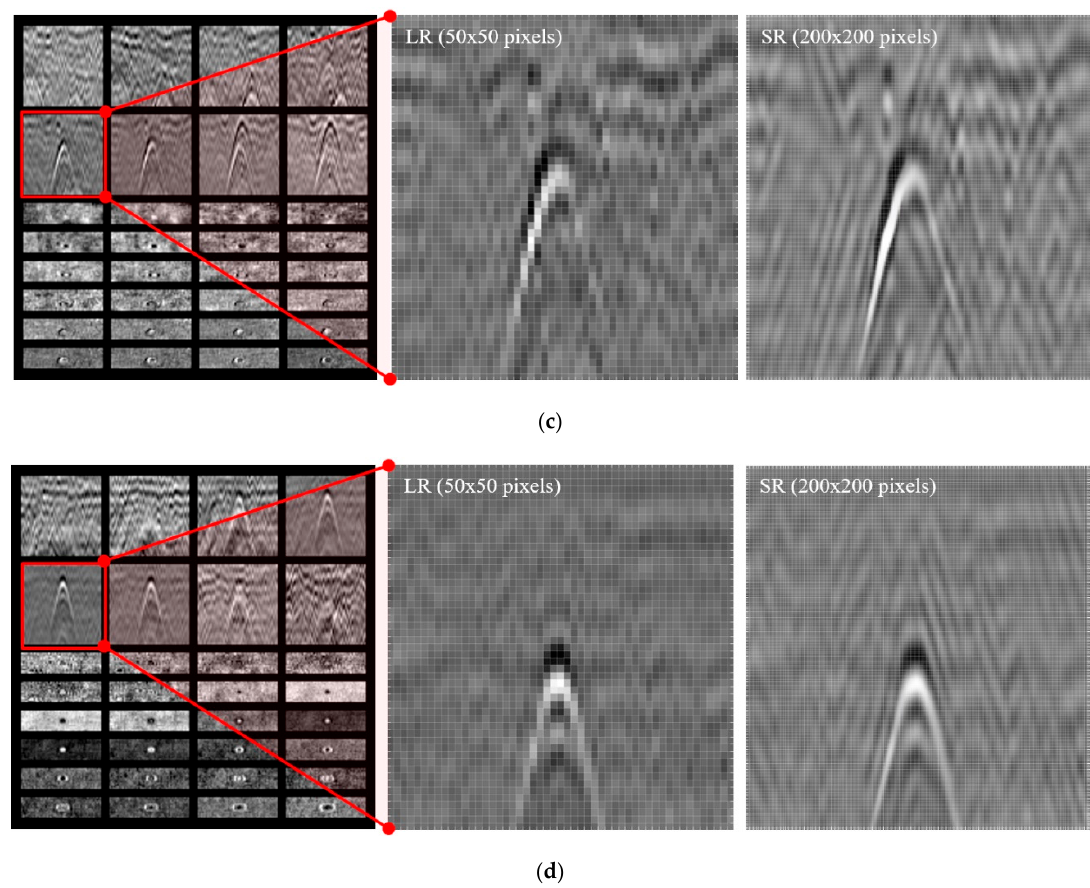
Figure 13. Representative LR and SR B-scan images of ( a , b ) cavity cases misclassified as gravels and ( c , d ) gravel cases misclassified as cavities.